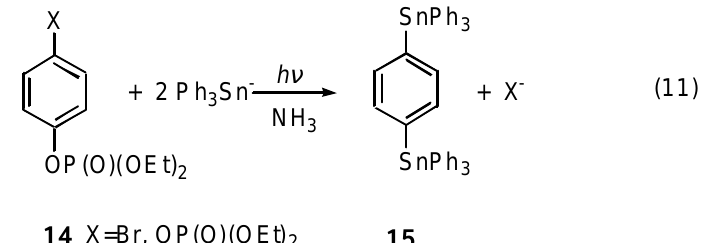
Table 2. Reactions of Ph